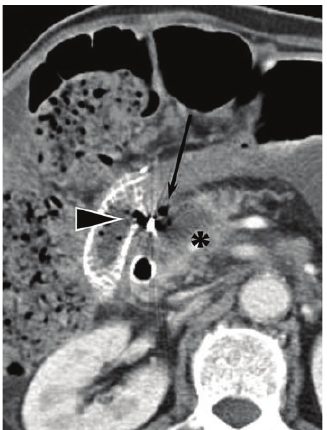
Figure 4: Necrosis (asterisk) in the pancreas head with rim enhancement, a fistula between the pancreatic tumor and the adjacent bowel with the mottled air densities (long thin arrows), and communication between the duodenum and the ablated cavity via focal disruption of the duodenal stent (arrowhead) in a follow-up CT after HIFU ablation (used with permission